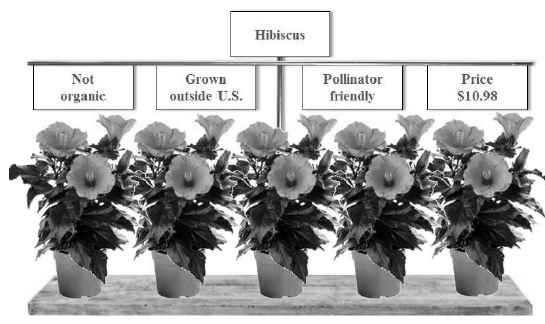
Figure 1. Example of the conjoint analysis product images.